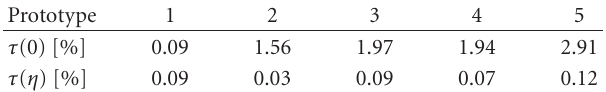
Table 3: Relative mean error between the modeled and measured resonance frequencies of the bent prototypes for the TE 10 mode.